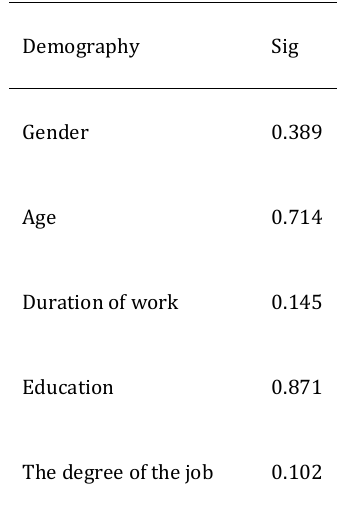
Table 9 The demography based analysis